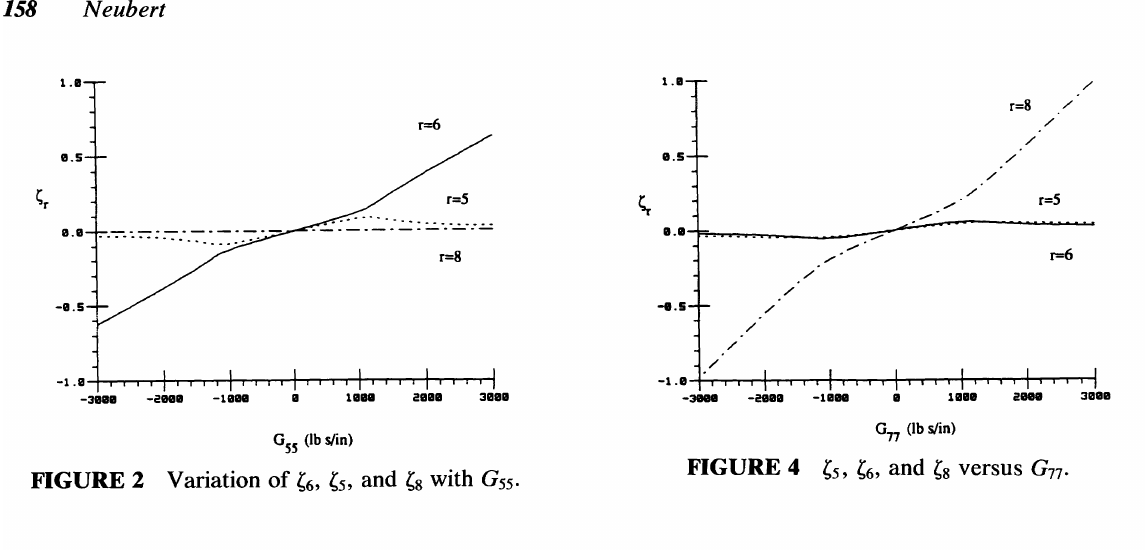
FIGURE 2 Variation of related directly to the slopes of the curves in Fig.